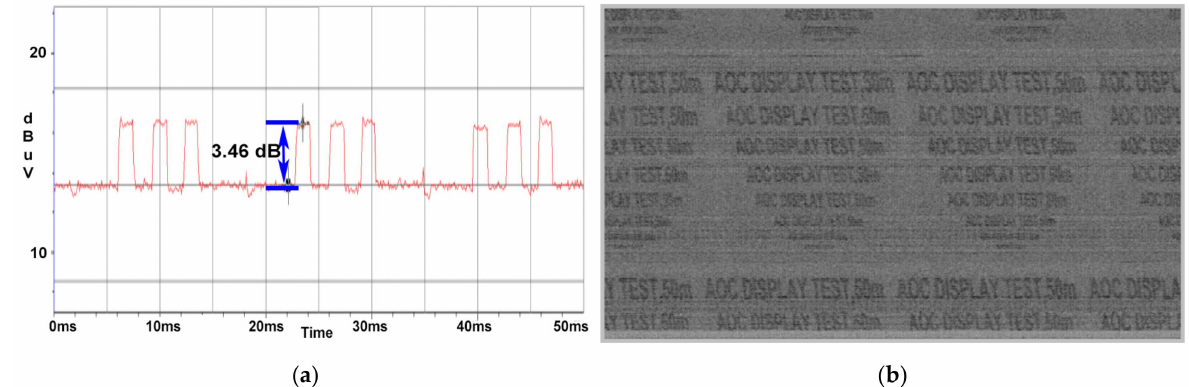
Figure 14. AOC display: ( a ) SNR measured at a distance of 50 m; ( b ) image recovered at a distance of 50 m.